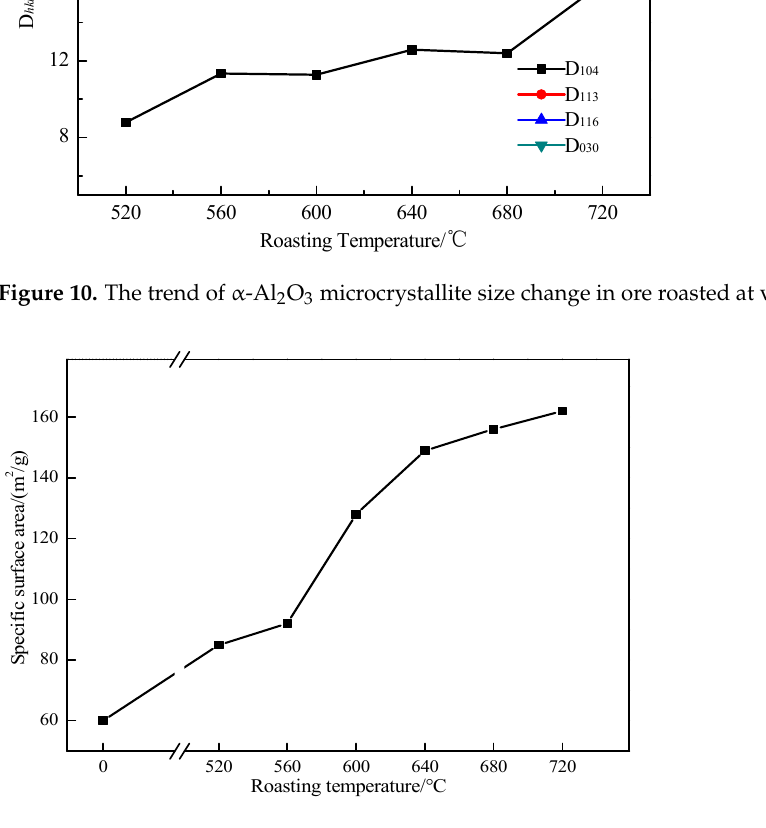
Figure 11. Specific surface area of bauxite at different temperatures calculated by BET.